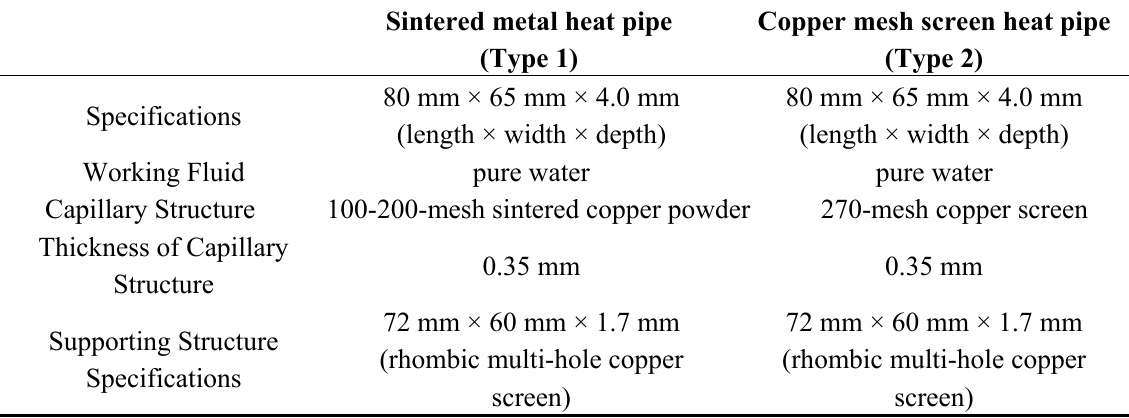
Table 1. The production parameters of the heat pipes using different capillary